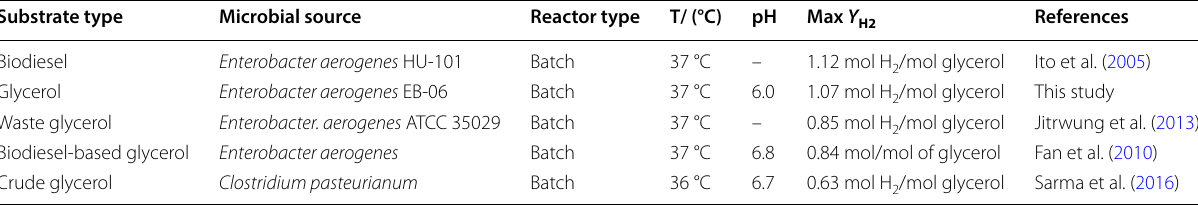
Table 8 Biohydrogen characteristics of some reported microorganisms from glycerol fermentation Substrate